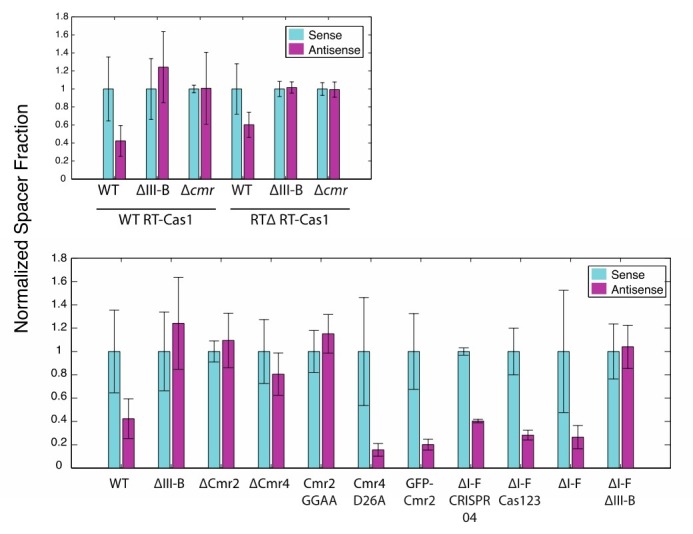
(As in Figure 2) Proportion of newly acquired spacers isolated from CRISPR03 mapping to sense and antisense strands of plasmid-borne genes.